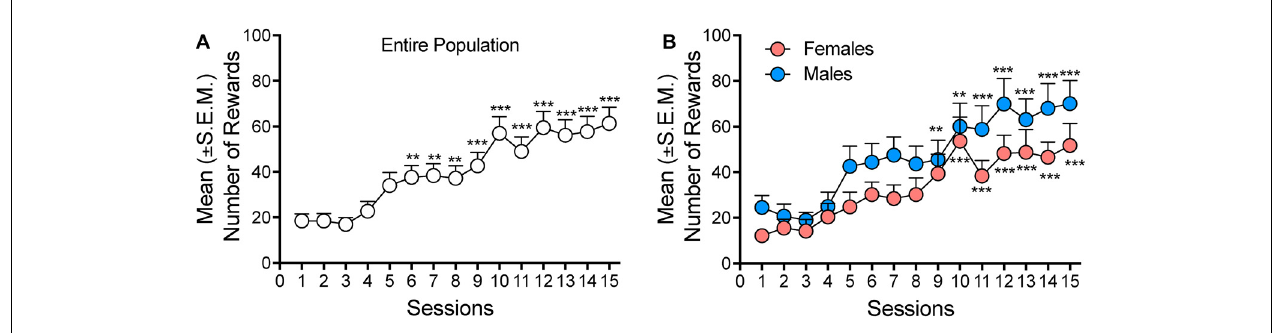
FIGURE 1 | (A) Escalation of oxycodone intake in heterogeneous stock (HS) rats. ∗∗ p < 0.01, ∗∗∗ p < 0.001, vs. day 1. (B) Escalation of oxycodone intake in male (blue) and female (salmon) HS rats. ∗∗ p < 0.01, ∗∗∗ p < 0.001, vs. day